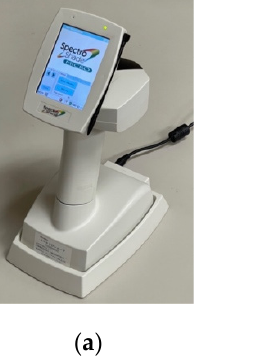
Figure 3. ( a ) Dental spectrophotometer and ( b ) its measurement screen.